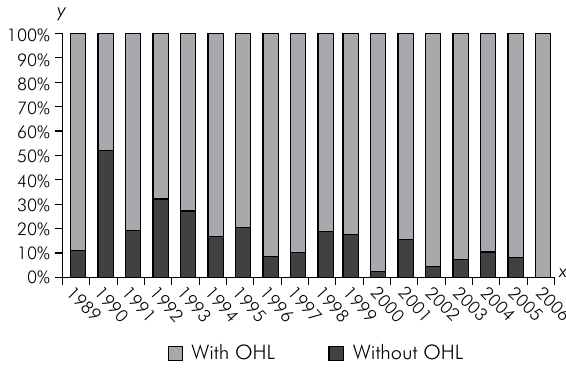
Figure 1. Annual percentage of new and HIV-positive patients who presented hairy leukoplakia in the period 1989- 2006 (n =